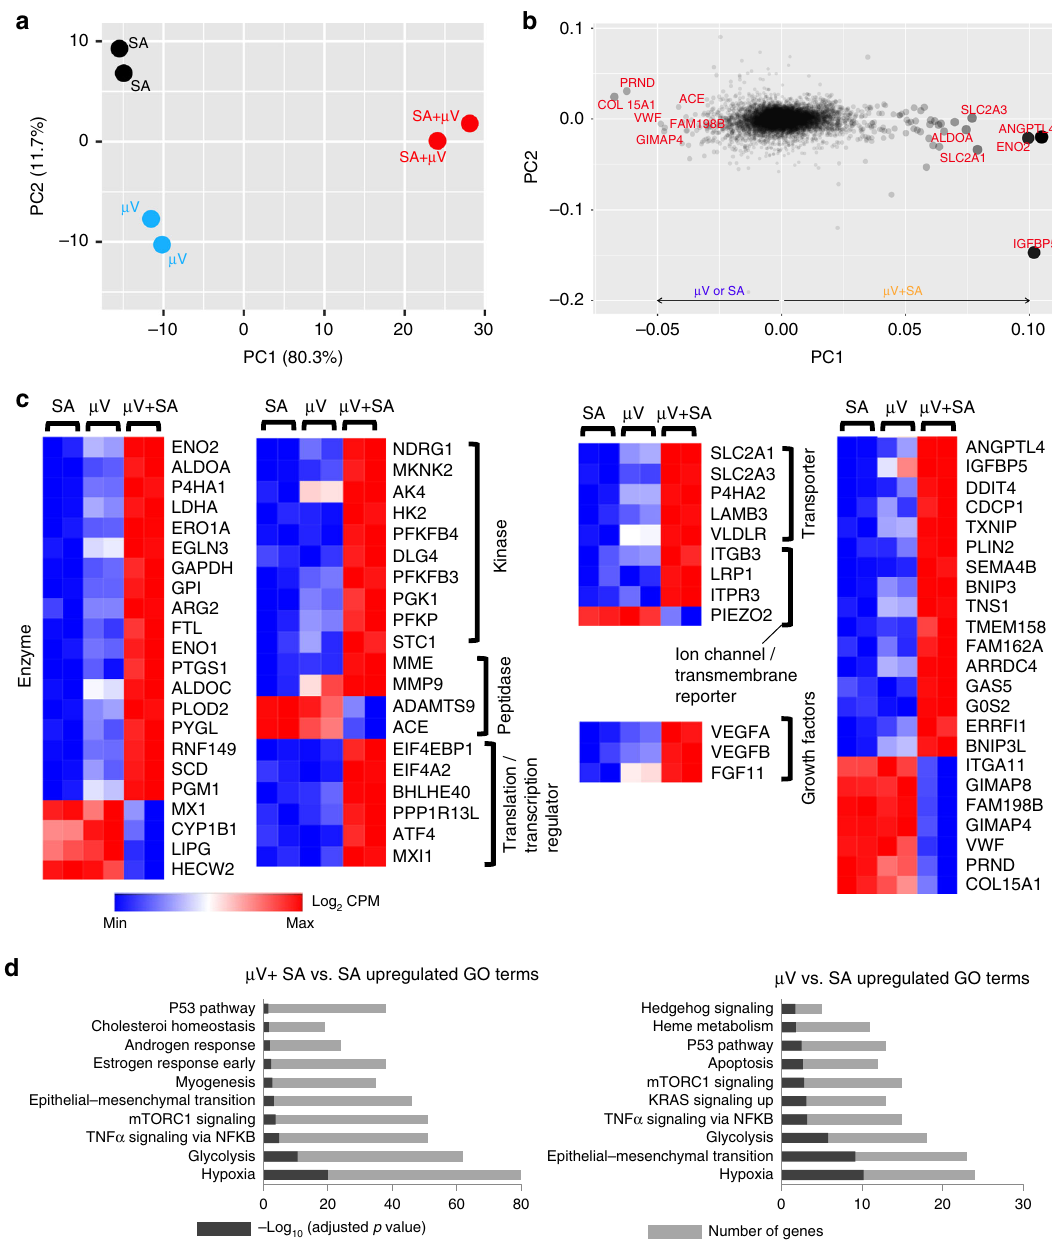
Fig. 4 Global RNA sequencing reveals differential gene expression pro fi les among self-assembled (SA), µ V only, and µ V + SA constructs after 3 days of culture in vitro. a 2D principal component analysis (PCA) of RNA sequencing data for cultured constructs showing clustered groups for each condition. b , c Top genes contributing to PC1: b Size of the circle is proportional to the contribution. c Heat map of the top 75 genes (log 2 CPM) contributing to PC1 in categorized functions. Colormap normalized to minimum and maximum expression. Red, high expression. Blue, low expression. d Gene ontology terminology analysis (GO) showing different gene clusters for μ V + SA vs. SA (left) and μ V vs. SA (right). Each sample is two constructs pooled. CPM counts per million (Fig. 5d). This overlay reveals drastic improvement in vascular velocity (vessel diameter between 20 μ m and 40 μ m) in μ V + SA perfusion of μ V + SA grafts compared to SA grafts. Quanti fi cation grafts (0.72 ± 0.09 mm/s) was similar to that of the non-infarcted of the overall vessel area density in OMAG images con fi rmed that myocardium and signi fi cantly higher than that of SA grafts (0.29 μ V + SA grafts had signi fi cantly more perfused vessels (33.8 ± ± 0.10 mm/s) (Fig. 5f). The perfusion rate for the fi eld of view was 5.6% of tissue area) compared to SA grafts (5.3 ± 1.7% of tissue 24.5 ± 8.8 µL/min in μ V + SA grafts, corresponding to a volu- area). Vessel area density in neighboring non-infarcted regions of metric perfusion rate of approximately 12.3 ± 4.4 mL/min/mL both groups was comparable at 63.5 ± 9.2% and 64.5 ± 5.1% for tissue. This perfusion rate is >20-fold greater than that of the SA SA and μ V + SA grafts, respectively (Fig. 5e). Perfusion dynamics grafts which had a perfusion rate of 0.9 ± 0.8 µL/min (0.5 ± 0.4 of individual vessels in the grafts were assessed by using the linear mL/min/mL tissue) (Fig. 5g). Despite this improvement, perfu- correlation between velocity and signal intensity in OMAG-V sion rates in both grafts were signi fi cantly less than rates in non- scans (Supplementary Figure 9B) 35 . The average measured infarcted healthy regions of the same hearts (117.9 ± 32.6 µL/min NATURE COMMUNICATIONS| (2019) 10:584